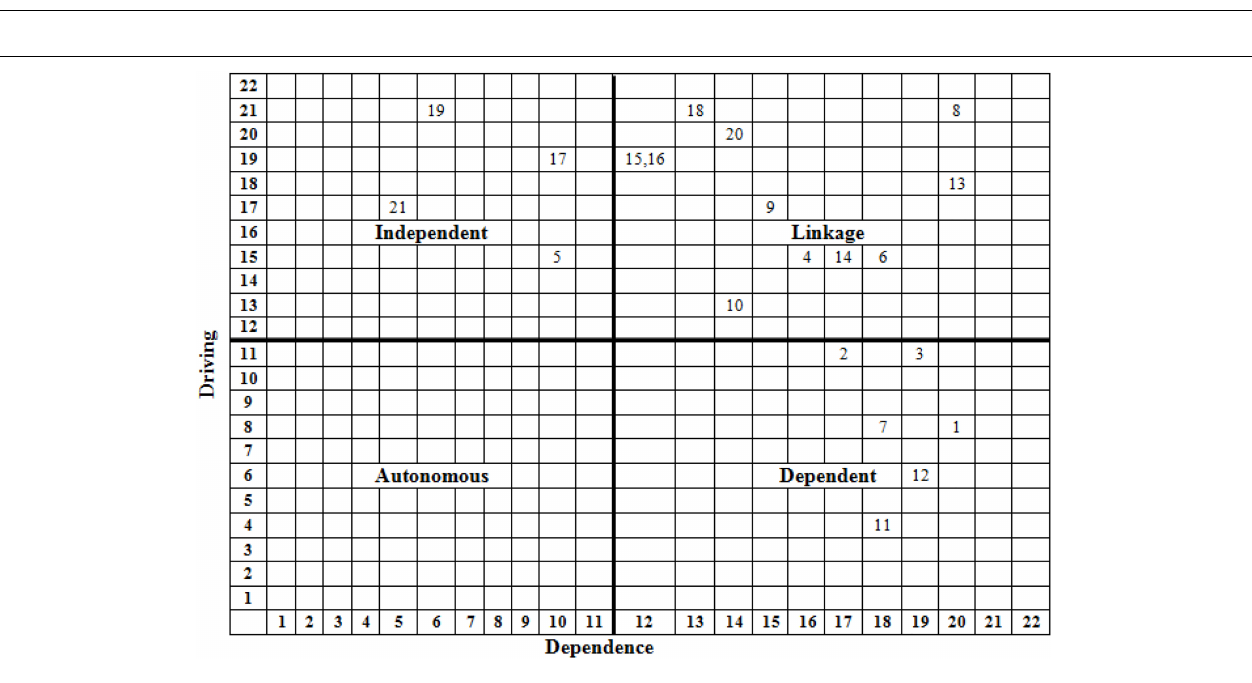
FIGURE 1 | Interpretive Structural Modeling (ISM).